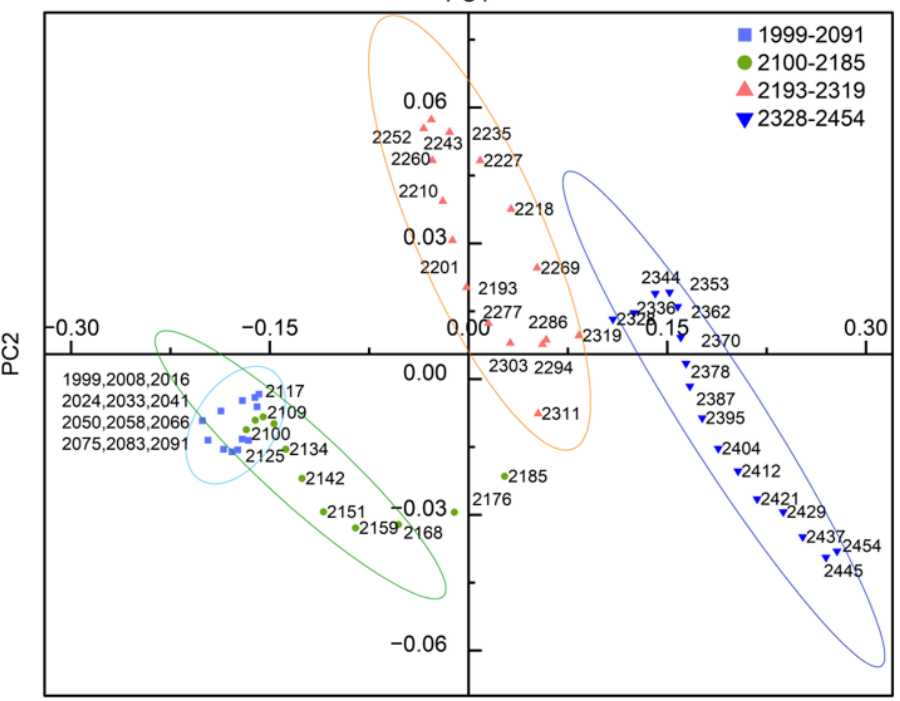
Figure 20. Loading of PC2 and PC4 in the GF-5 dataset. The coloured circles delineate 95% confidence ellipses; the numbers denote the wavelength of the scatters; the numerical value of the horizontal and vertical coordinates represents the loading.